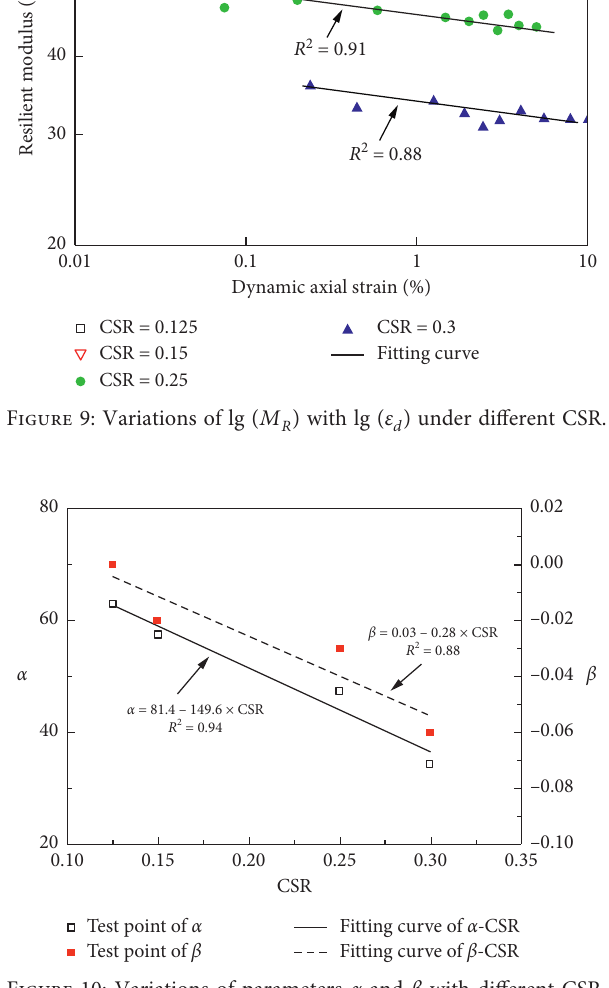
Figure 10: Variations of parameters α and β with different